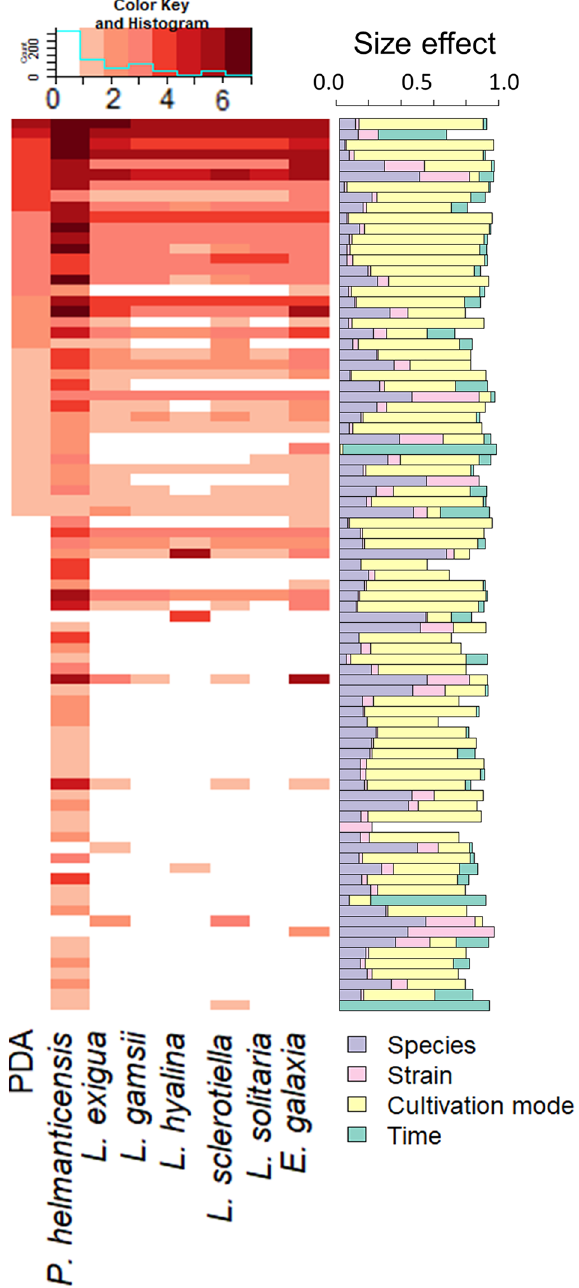
Figure 3. Concentrations of volatile organic compounds (VOCs) measured for sterile PDA medium and for pure cultures of P. helmanticensis and the Linnemannia and Entomortierella species studied here, and how they are affected by experimental factors (species, strain, cultivation mode and time). The concentrations of VOCs were measured by PTR-ToF-MS. The heatmap illustrates the mean concentrations of VOCs (rows) in PDA medium, P. helmanticensis pure cultures, and pure cultures of the fungal species (columns). For visualisation purposes, the concentrations were grouped: 0 = concentration < 0.2 bbpV; 1 = 0.2 ppbV ≤ concentration < 0.5 ppbV; 2 = 0.5 ppbV ≤ concentration < 1 ppbV; 3 = 1 ppbV ≤ concentration < 5 ppbV; 4 = 5 ppbV ≤ concentration < 10 ppbV; 5 = 10 ppbV ≤ concentration < 20 ppbV; 6 = 20 ppbV ≤ concentration < 50 ppbV; 7 = concentration ≥ 50 ppbV. The barchart visualizes the effect size of the experimental factors on the respective VOC concentration as calculated by ANOVA. The proportion of sum of squares explained by each factor was used as effect